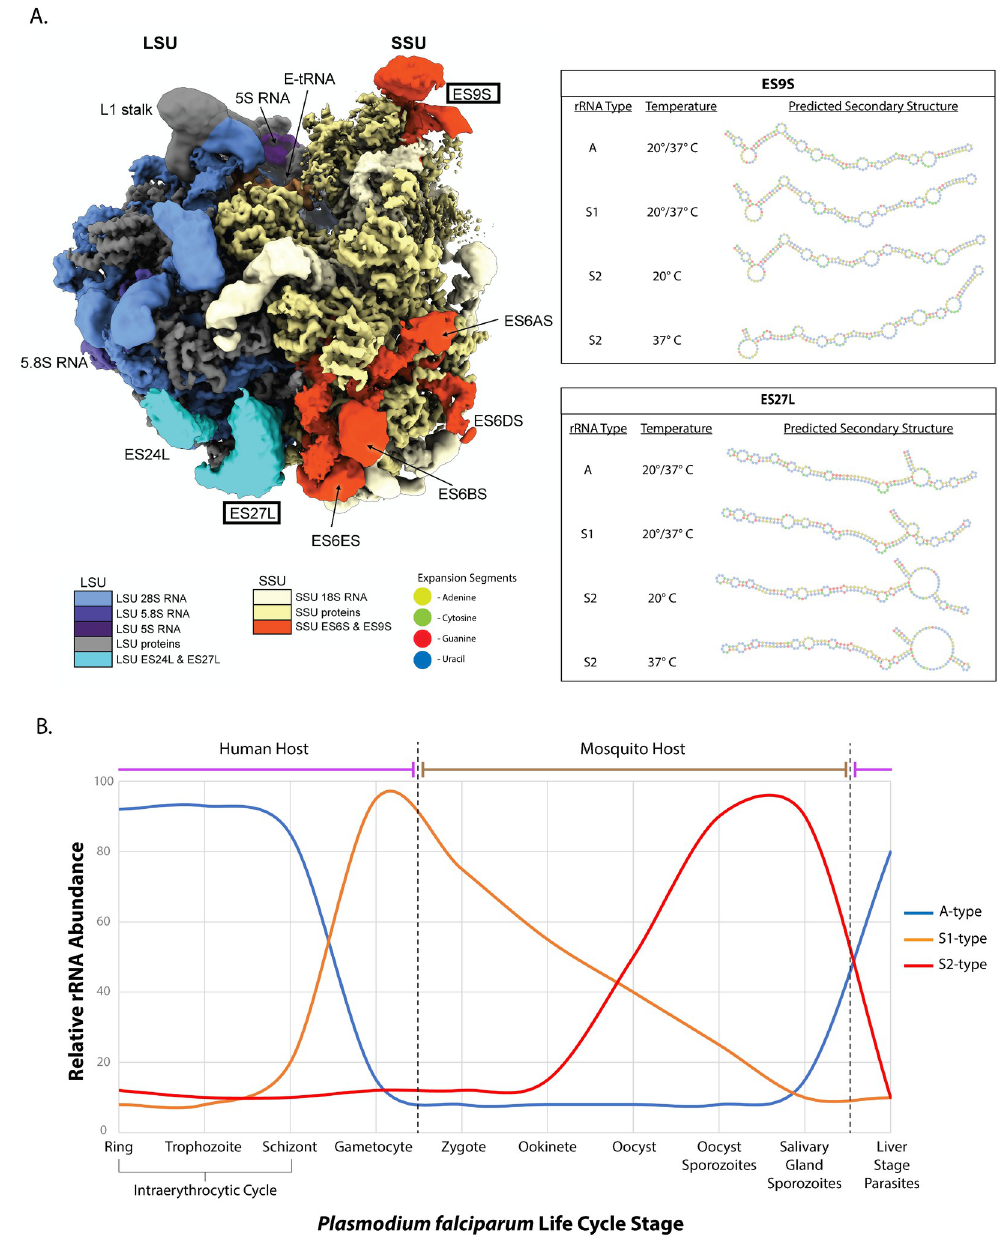
Fig 1. Key features of P . falciparum ribosomes. ( A ) A model of the Pf80S A-type ribosome was rendered and labeled in ChimeraX using data obtained from previously published structural characterizations [28]. Four ESs are highlighted on the ribosome structure, and the secondary structural predictions of two ESs are shown to represent the variability in the sequences between the P . falciparum A-type, S1-type, and S2-type rRNA. A-, S1-, and S2-type rRNA sequences were aligned via BLAST [39] to determine sequence differences. Minimal free energy secondary structures of the ES sequences were predicted at 37˚C and 20˚C using Vienna RNAfold v2.4.18 [40] and were manually base paired at the protrusion location from the core rRNA [28] using the Force-directed RNA (Forna) software [41]. (B) The P . falciparum rRNA types (A, S1, and S2) were given relative abundance values at each parasite stage to visualize their temporal expression pattern. Relative values are approximated from published data that investigated either rRNA abundance in P . falciparum [2,30,31]or P . berghei [33,42] in stages when rRNA abundances in P . falciparum are not known (e.g., zygote, ookinete, early oocyst, and liver stage parasites). The dashed vertical lines mark transmission events between humans and